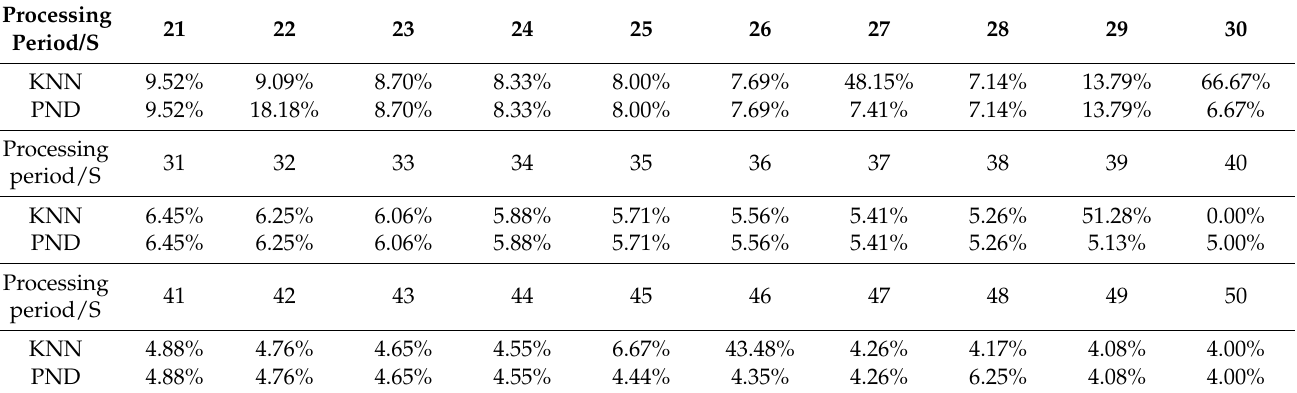
Table 9. Maximum false correlation rate under different processing periods in Scenario